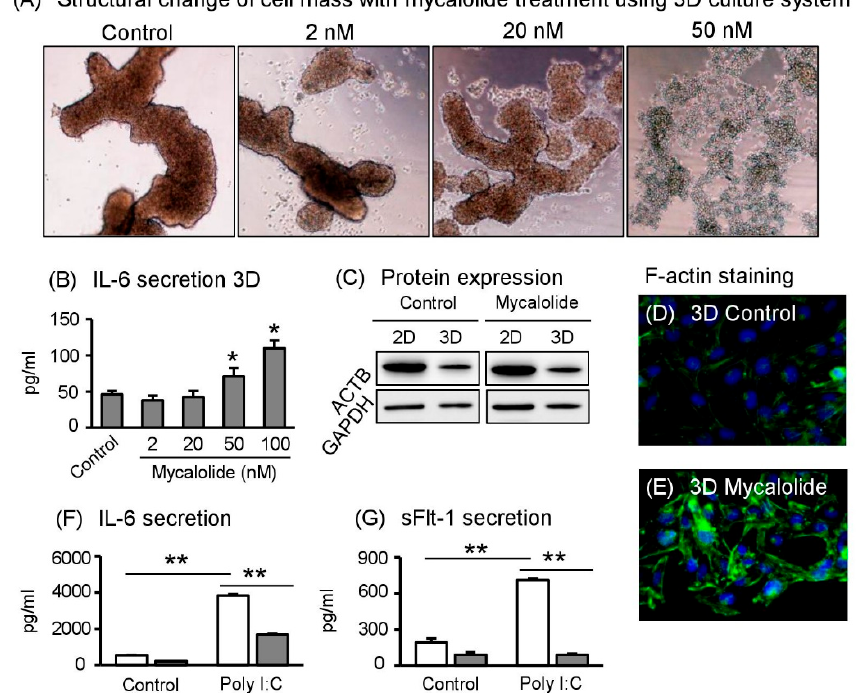
Figure 5. Effects of mycalolide B and poly I:C on Sw.71 cells. ( A ) Sw.71 trophoblast cells were incubated for 24 h in 3D culture plates with or without mycalolide B. Observation of structural change of Sw.71 cells under 3D culture plate (×40 magnification). ( B ) IL-6 concentrations in supernatants (/mL) treated with mycalolide B were determined using ELISA ( n = 4). ( C ) ACTB and GAPDH protein levels in the cell lysates were detected using Western blot. Representative data are shown. ( D , E ) Representative images of stained F-actin filaments with or without mycalolide B treatment (x 200 magnification). ( F , G ) IL-6 and sFlt-1 concentrations in supernatants (/mL) from cells treated with poly I:C were determined using ELISA ( n = 4). Data are expressed as mean ± SEM. Significant differences were detected using a t -test; p < 0.05 (*) p < 0.01 (**).